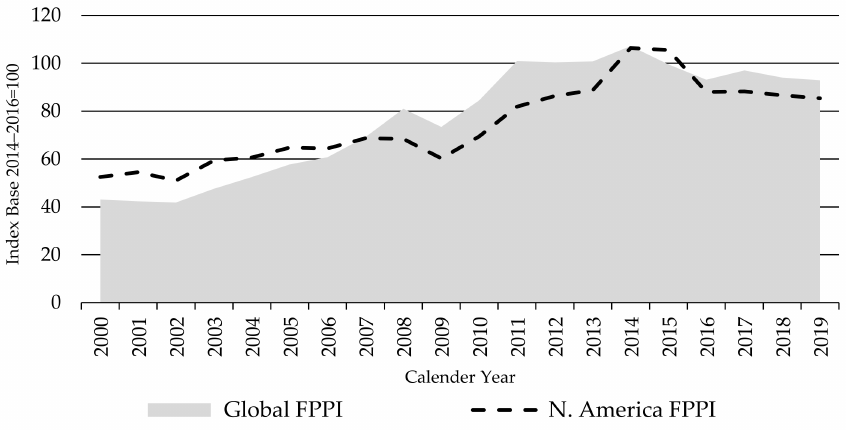
Figure 2. TheGlobalandNorthAmericaFinishedCattleProducerPriceIndicesFPPIs,source: